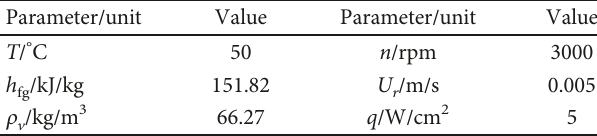
Table 1: Calculating parameters for the speci fi c